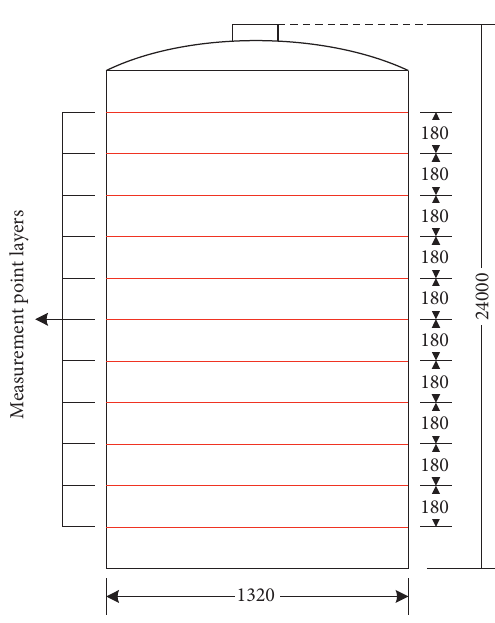
Figure 3: Layout of measurement